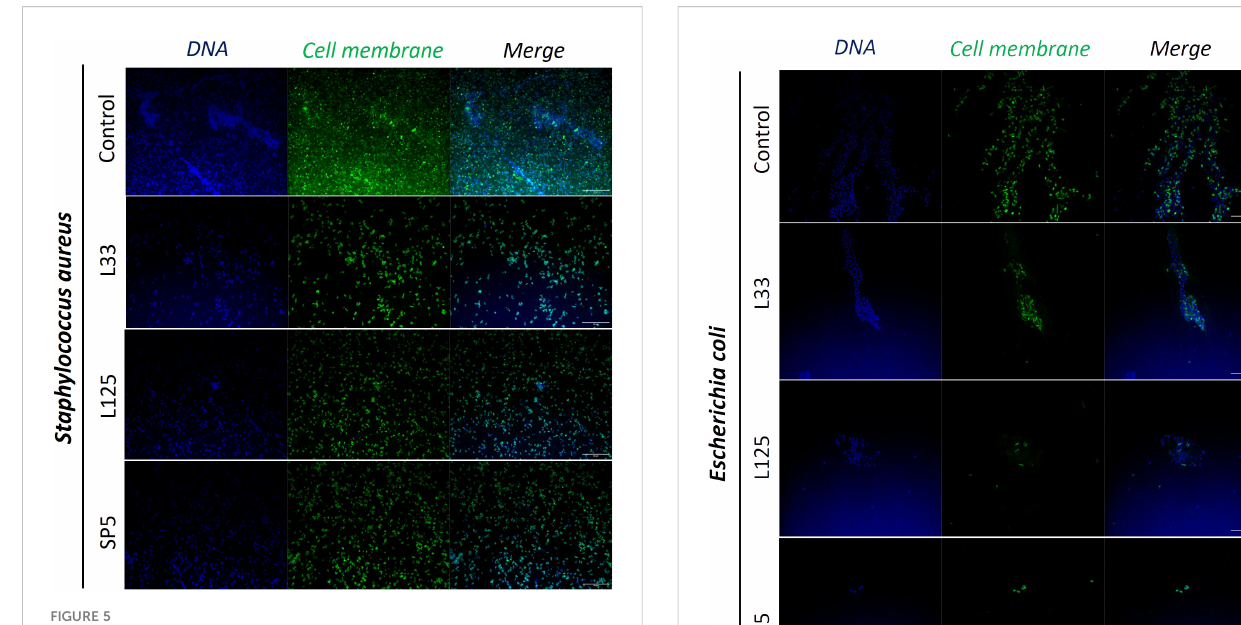
FIGURE 5 Representative images of S. aureus cells organized in bio fi lms, after 24 h incubation in TSB (control) or adjusted CFCS (50% v/v, pH 6.2) derived from Lp. pentosus L33, Lp. plantarum L125 or Lc. paracasei SP5. Pathogen cell membranes were stained with CFSE (green) and DNA with Hoechst 33342 (blue) (scale bar, 20 m m).